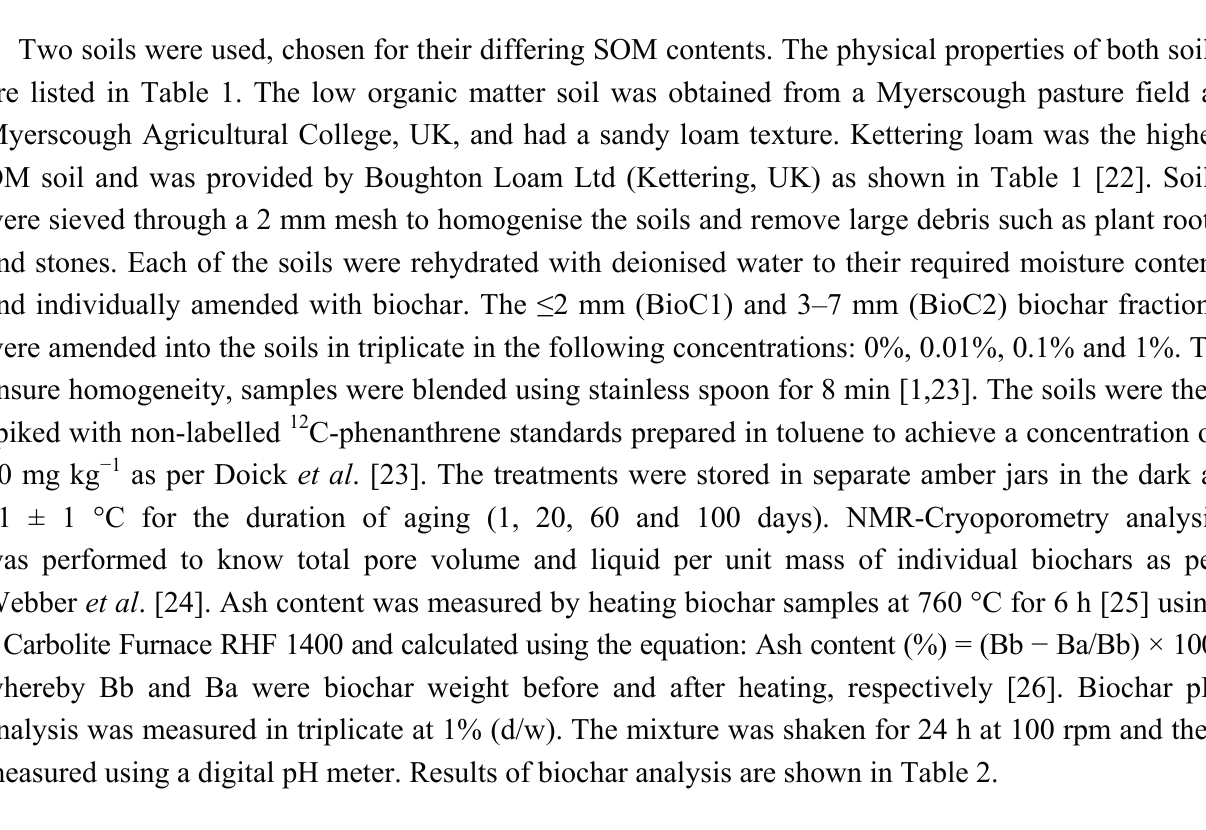
1. Physical properties of Myerscough (Clay-Loam) and Kettering Loam (Sandy-Loam). Data also available in Boucard et al . [22] and Couling et al .